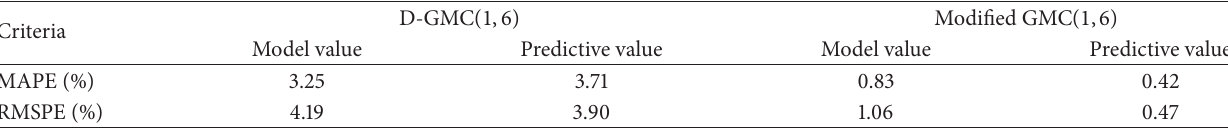
Table 3: Performance evaluation for fitting and Prediction accuracies of D-GMC (1,6) and modified GMC (1,6) models.